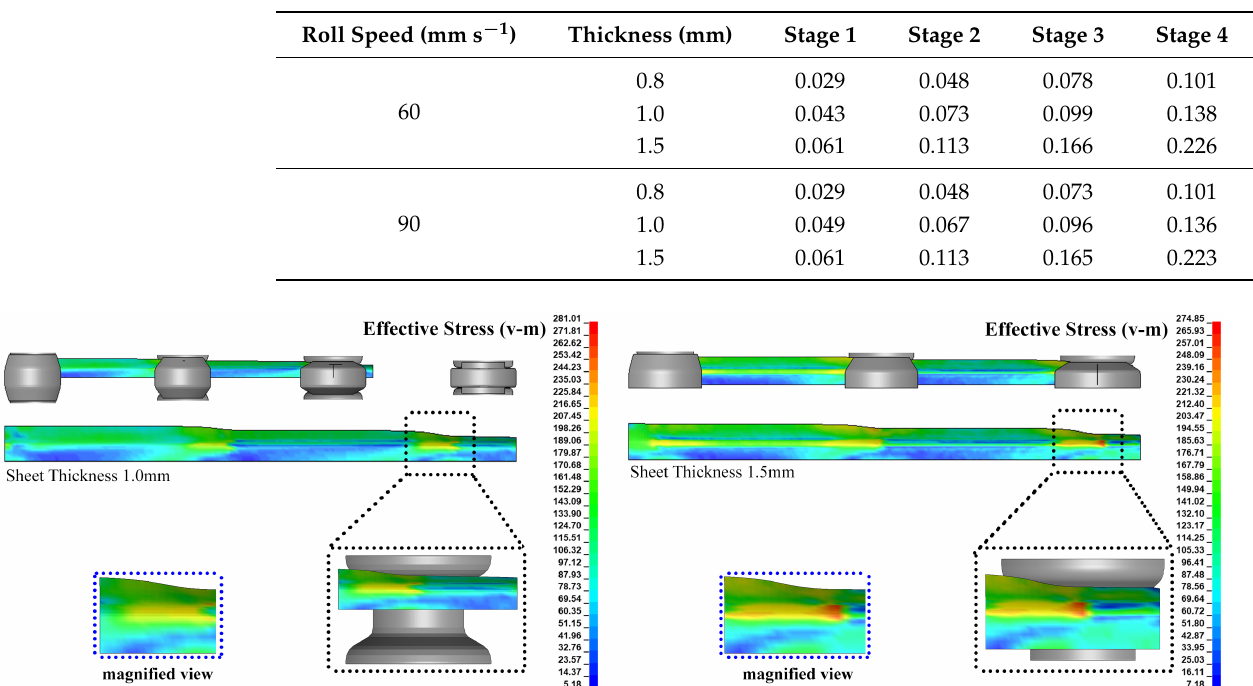
Table 4. Finite element (FE) model results of peak strain ( ε ) in each forming station.